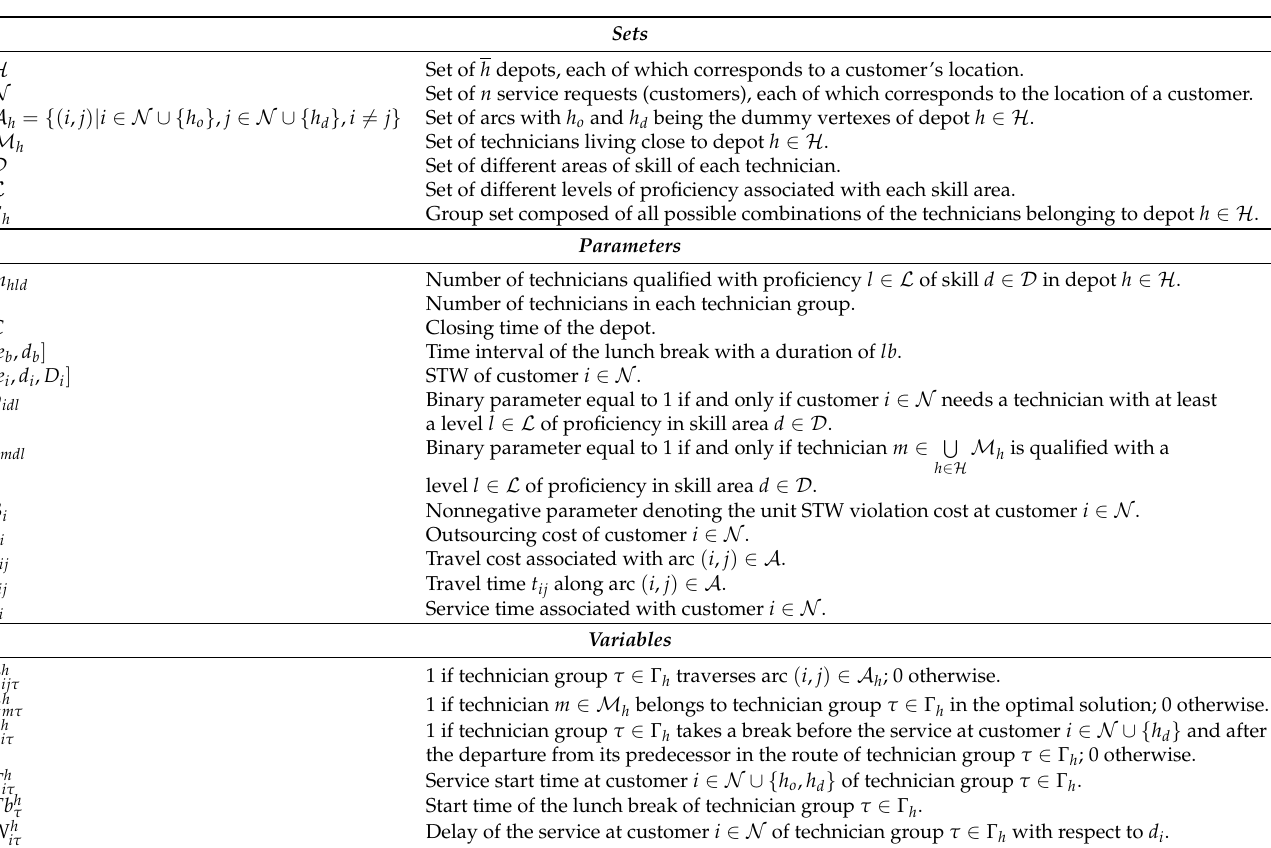
Table 1. Parameters and decision